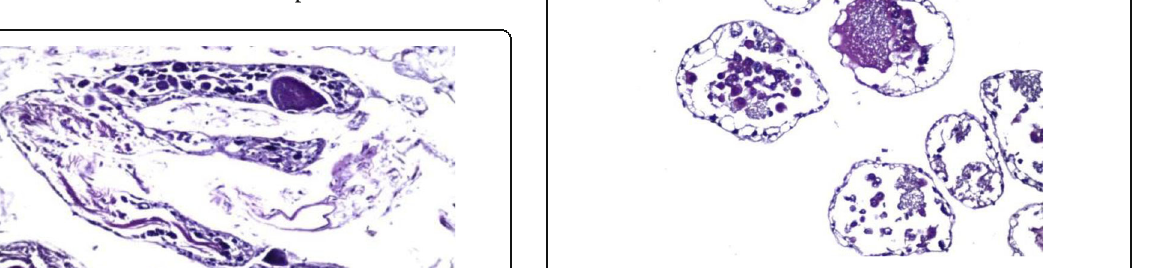
Fig. 4 Ovotestis of Eobania vermiculata treated snail with chitosan LC 50 using the thin film